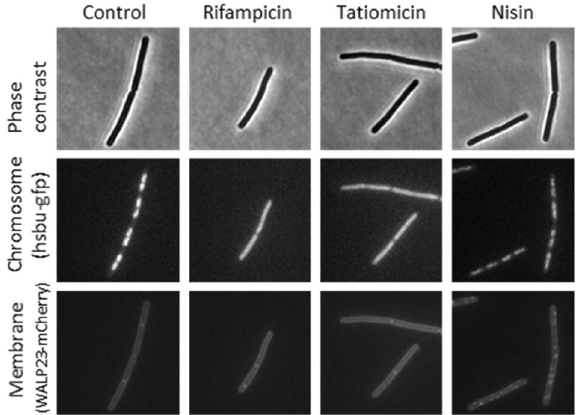
Figure 7. Single-cell analysis of chromosome and membrane integrity. Phase contrast (top panels) and fluorescence microscopy of B. subtilis cells treated with various antibiotics (indicated above). DNA was visualized with an HsbU-GFP fusion (middle panels) and the cytoplasmic membrane with a WALP23-mCherry fusion (bottom panels).